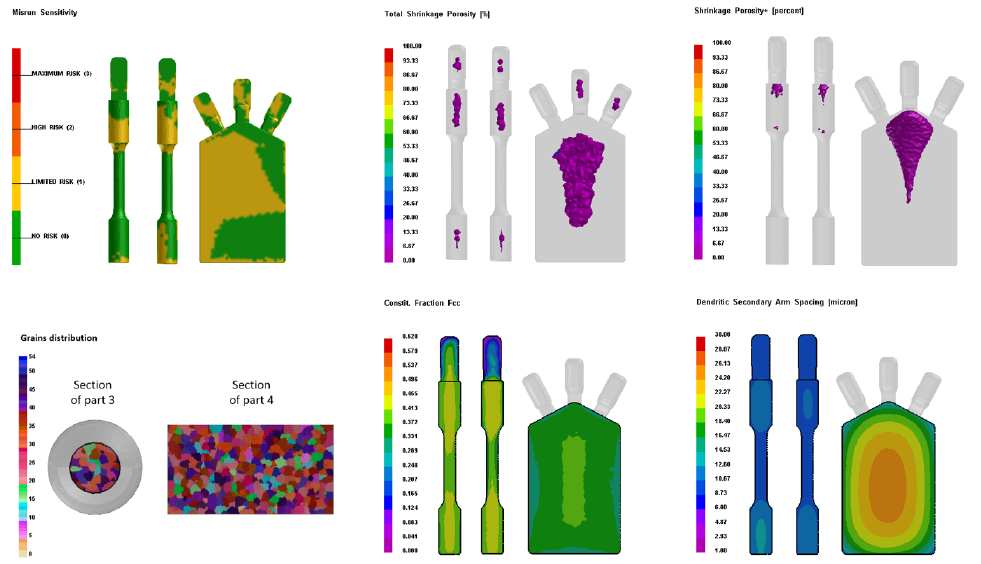
Figure 10. Examples of the results provided by the physics-based model.